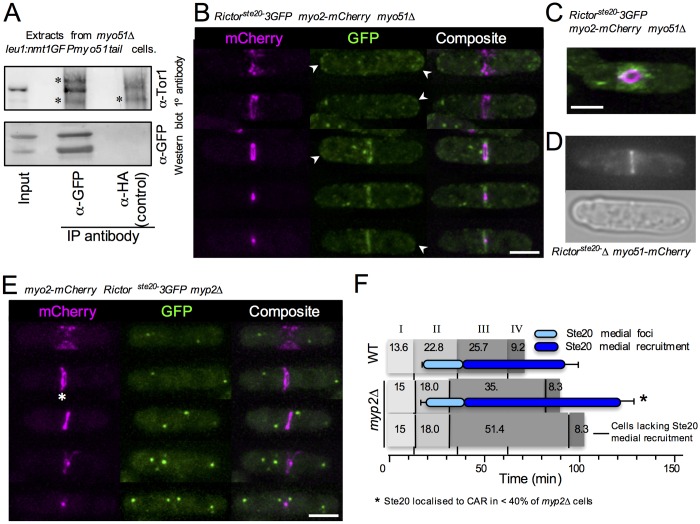
Myosin II and V interact with and regulate RICTORSte20 localisation at the CAR. (A) Extract and subsequent anti-GFP and anti-HA (control) immunoprecipitates from S. pombe cells expressing a GFP-tagged Myo51 cargo-binding-tail domain fusion protein were subject to anti-Tor1 (upper panels) and anti-GFP (lower panels) antibody western blot analysis. The asterisks denote background bands. (B–E) Micrographs of mCherry and GFP signals in cells with the indicated genotype. The asterisk highlights rings split in two. Arrowheads highlight RICTORSte20 localisation at cell tips. (F) The timing of the appearance of RICTORSte20 medial foci (light blue bars) or RICTORSte20 ring recruitment (dark blue) were determined in wild-type and myp2Δ strains in relation to the events determined in Fig. 2E. Scale bars: 5 µm.